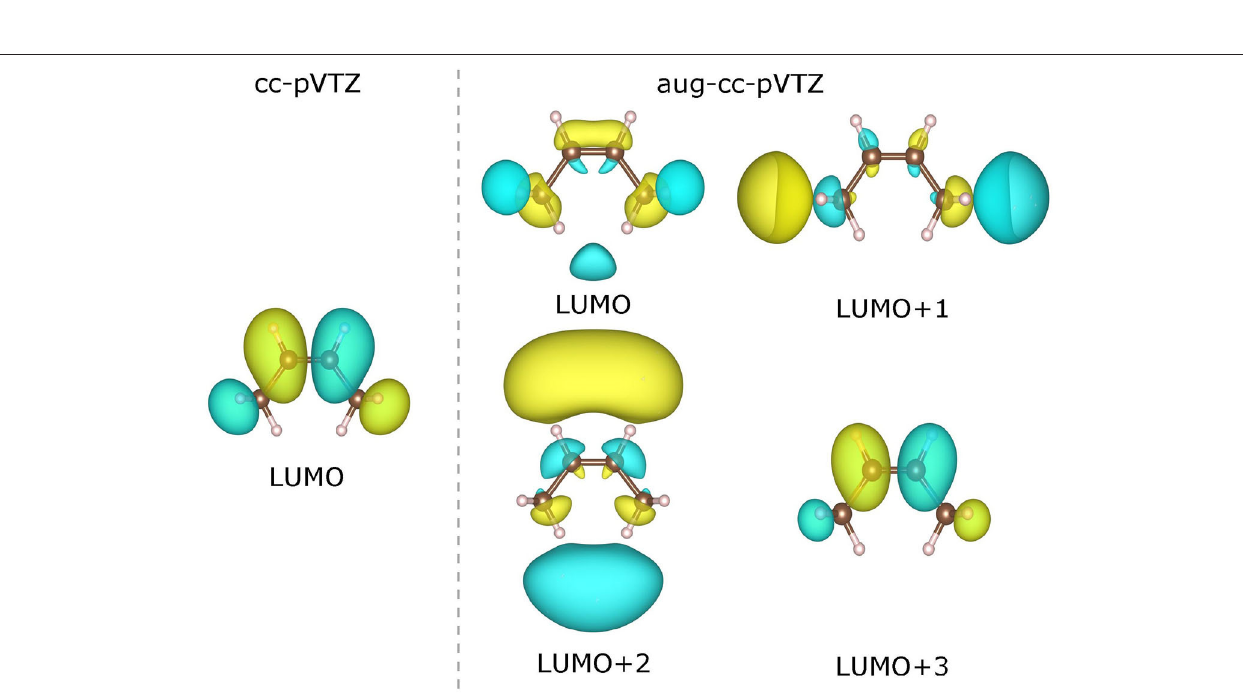
FIGURE 6 | Contour plots of the lowest virtual Kohn–Sham (KS)/generalized KS (GKS) orbitals of the neutral cis -butene molecule calculated at the B3LYP/cc-pVTZ and B3LYP/aug-cc-pVTZ levels. The isosurfaces of ± 0.022a.u. are shaded in yellow and green, respectively).